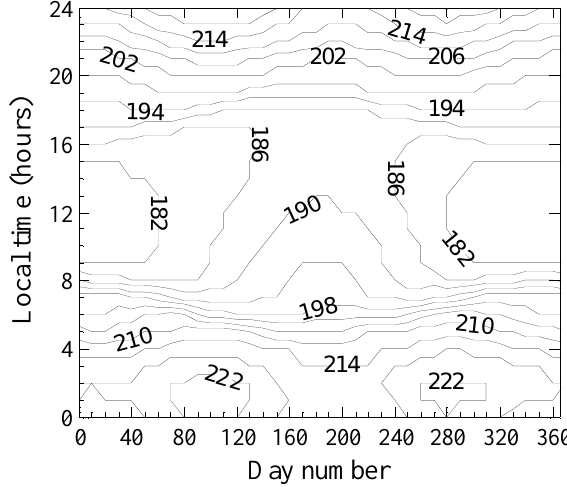
Figure 6. Contour of the calculated LTH versus day of year and local time under F107=100 and Ap=10.